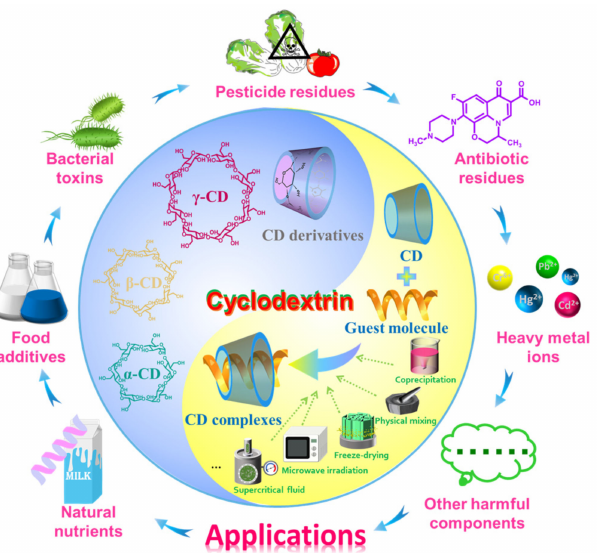
Figure 1. A brief timeline for the development of